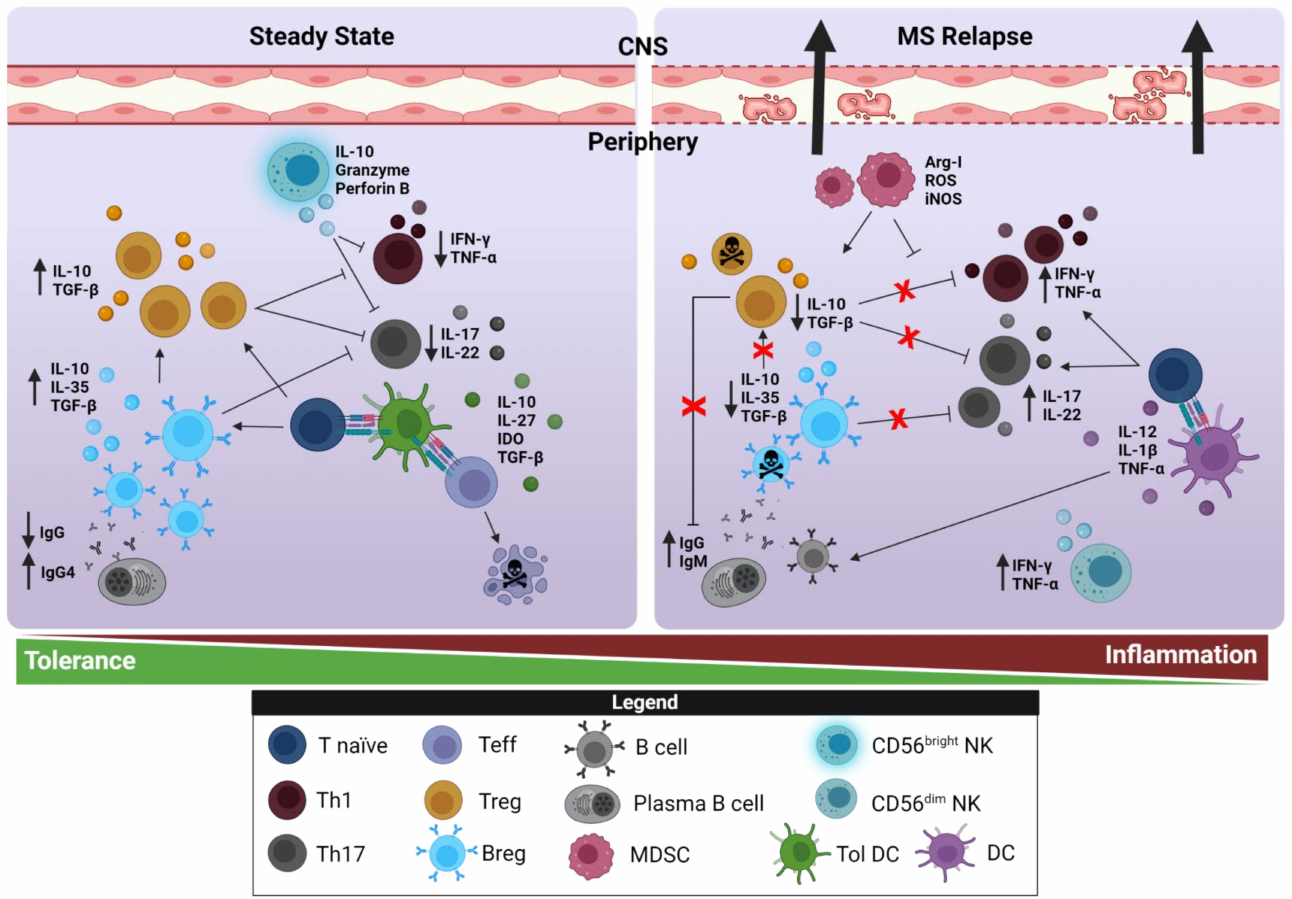
Figure 1. Pathogenic and protective roles of cells of the innate and adaptive immune response in steady-state conditions and during MS relapse. Alterations to or the disruption of immune regulatory mechanisms may lead to the survival and activation of autoreactive lymphocytes, which may cause and perpetuate autoimmune diseases such as MS. APCs phagocytose myelin autoantigens in the CNS released from the damaged myelin. This activates Th1 and Th17 cells, which in turn release pro- inflammatorypro-inflammatory factors such as IFN- γ , TNF- α , and IL-17. B cells secrete antibodies, and NKs and DCs release inflammatory cytokines, such as IL-12 and TNF- α . By contrast, there are several cell types from the innate and adaptive immune response (Treg, Breg, MDSC, TolDC, and CD56 bright NK cells) that possess a regulatory capacity, exerting protective effects. These cells have an immunoregulatory effect due to the release of anti-inflammatory cytokines, such as IL-10, IL-27, IL-35, or TGF- β , or through cell-to-cell contacts. In both cases, the action of regulatory cells inhibits the inflammatory response by reducing pro-inflammatorypro-inflammatory cytokine release, inducing T cell anergy or apoptosis. Figure created with Biorender.com (accessed on 12 January 2022). In steady-state conditions, there are two pools of Treg: natural Treg (nTreg), which orig- inate in the thymus during development and mainly recognize self-antigens, and peripheral Treg (pTreg), which are inducible Treg that differentiate from naïve CD4 + T cells under spe- cific conditions of antigen stimulation and in the presence of a particular peripheral cytokine milieu [12]. Initially, Treg were described as CD4 + CD25 + cells that constitutively express the forkhead box P3 (FoxP3) transcription factor [11]. In humans, a consensus established that all circulating CD4 + FoxP3 + Treg are characterized by high levels of CD25 and low levels of CD127 (CD4 + CD25 hi CD127 lo FoxP3 + ) [13]. Interestingly, Treg instability has been described, and they may downregulate FoxP3 expression under inflammatory conditions and, hence, their regulatory function, thereby acquiring characteristics of Teff [14,15]. Such cells are referred to as “exTreg” (CD4 + CD25 lo FoxP3 lo ), and they express